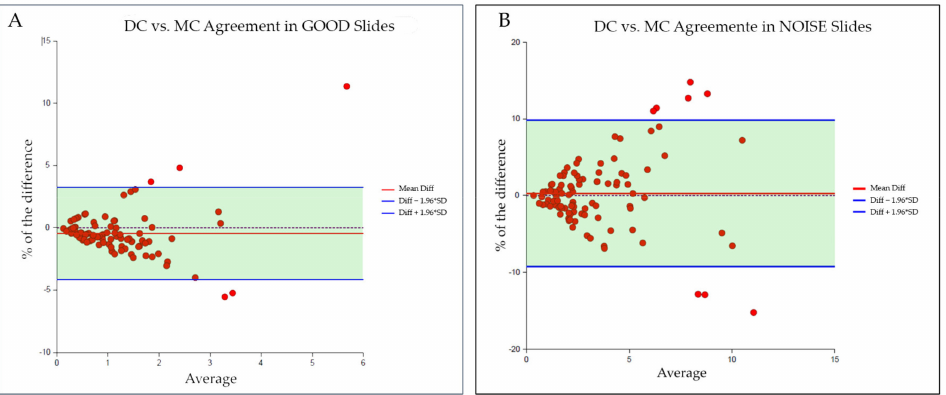
Figure 2. Bland–Altman plot of the paired samples, bias, and limits of agreement: ( A ) agreement between DC and MC within GOOD slides; ( B ) agreement between DC and MC within NOISE